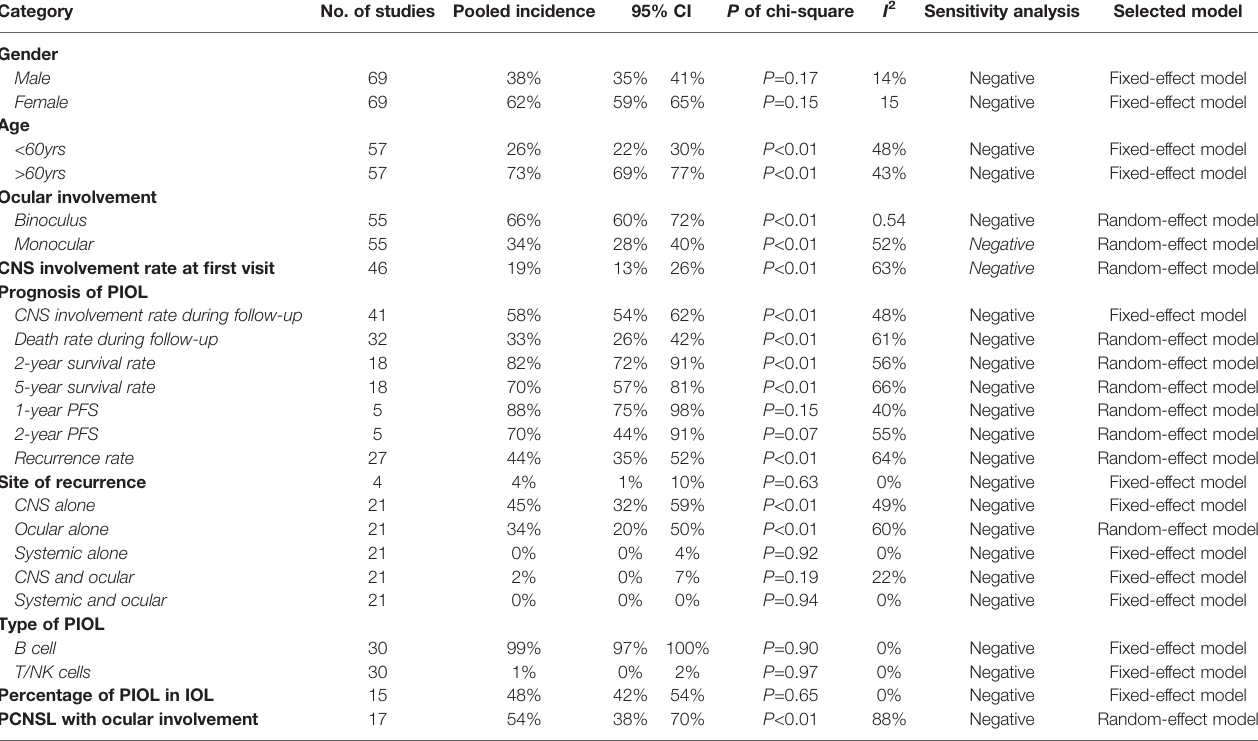
TABLE 2 | Population distribution and clinical characteristics of primary intraocular lymphoma patients.